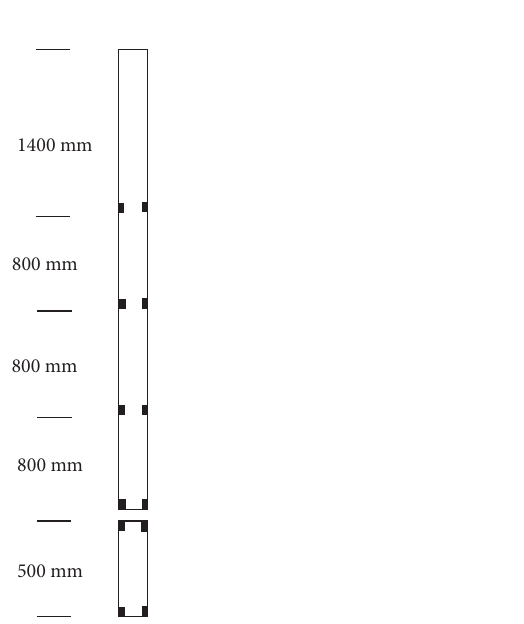
Figure 2: Schematic diagram of strain gauges position of self-anchored test pile.